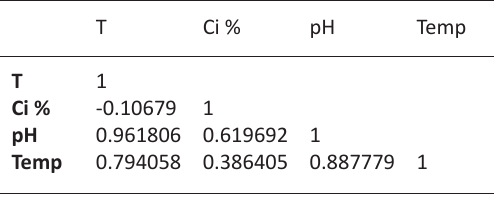
Table 1. Correlation the removal of kerosene effect with